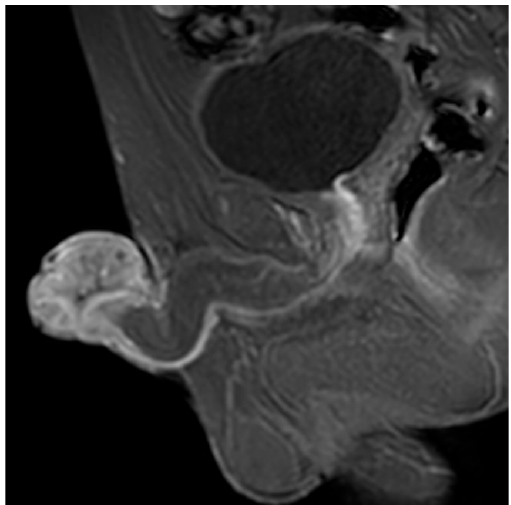
Figure 1. Magnetic resonance imaging (MRI) pelvis showing lobulated T2 (transverse relaxation time) intermediate mass at the level of the glans penis.